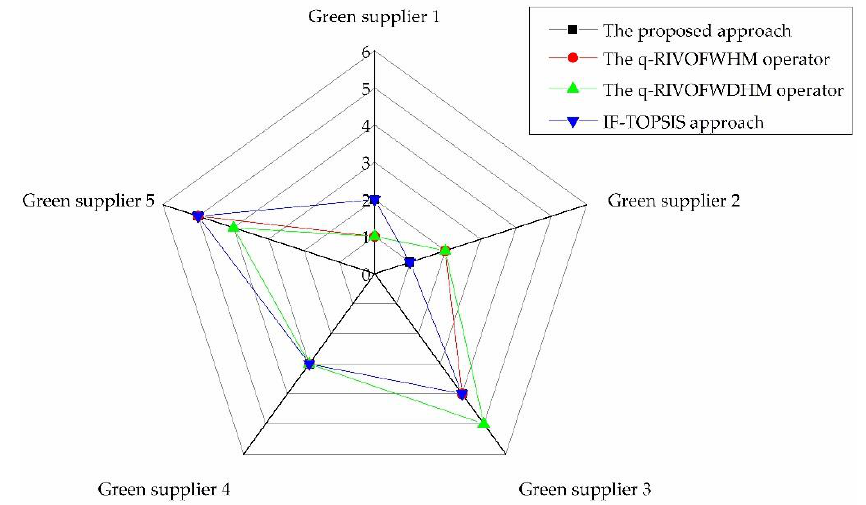
Figure 5. Rankings of different green supplier selection (GSS) approaches.